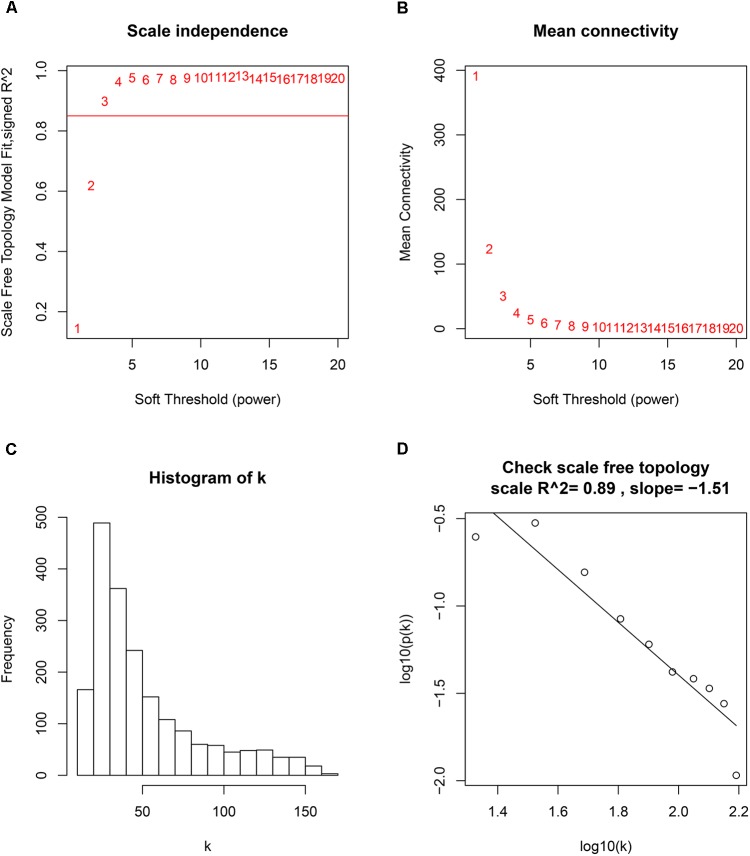
Determination of soft-thresholding power in the weighted gene co-expression network analysis (WGCNA). (A) Analysis of the scale-free fit index for various soft-thresholding powers (β). (B) Analysis of the mean connectivity for various soft-thresholding powers. (C) Histogram of connectivity distribution when β = 3. (D) Checking the scale free topology when β = 3.